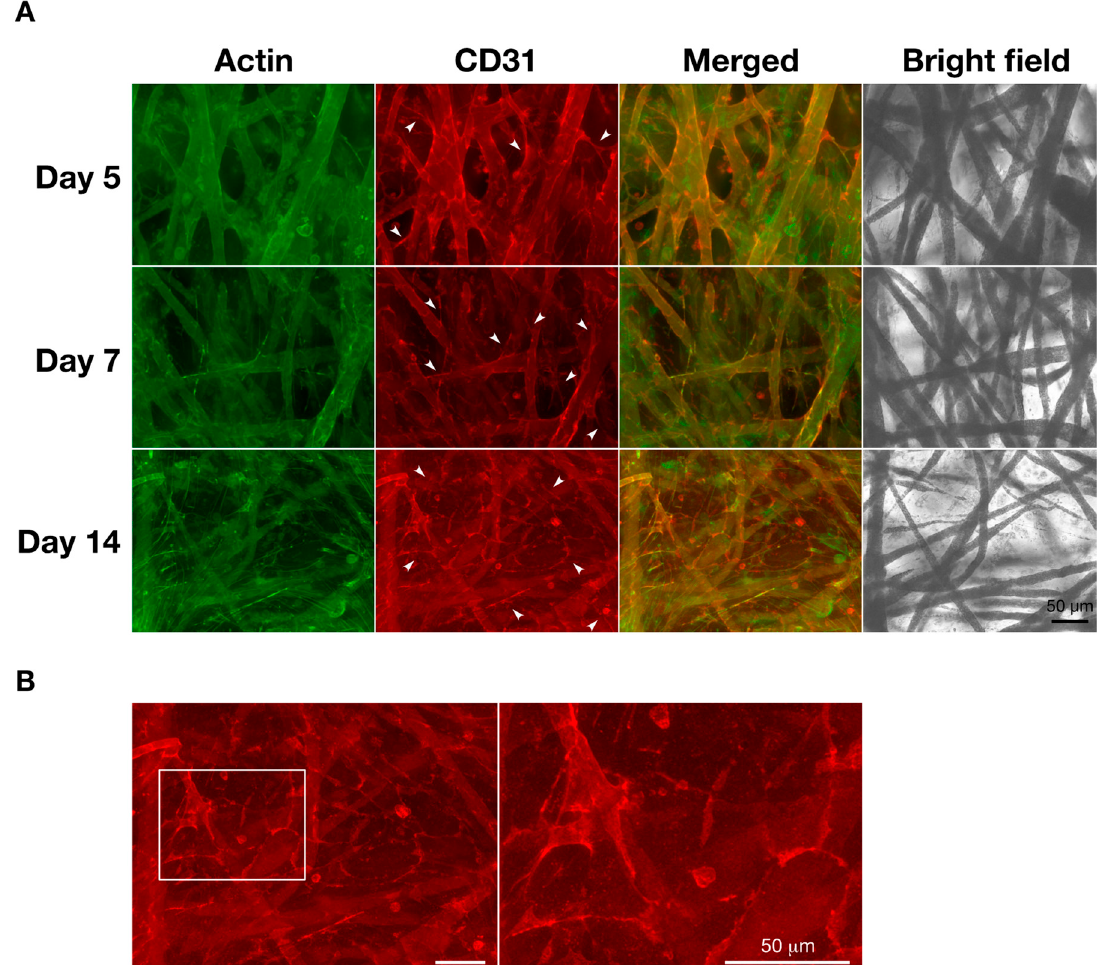
Figure 7. Morphological observation of monoculture and co-culture cells by immunofluorescence microscopy. Cells were seeded at 5.0 × 10 5 cells cm –3 on a microfiber mesh scaffold placed in each well of a 24-well plate and cultured for five, seven, and 14 days. At the culture time, the cells were fixed and stained with Alexa Flour ® 488-labeled phalloidin for actin (green) and anti-human CD31 for CD31 (red). They were viewed through a fluorescence phase-contract microscope at 20 × magnifications (scale bars: 50 µ m). Arrowheads ( A ) show microcapillary-like structures and square enclosure ( B ) indicates a vascular network area.